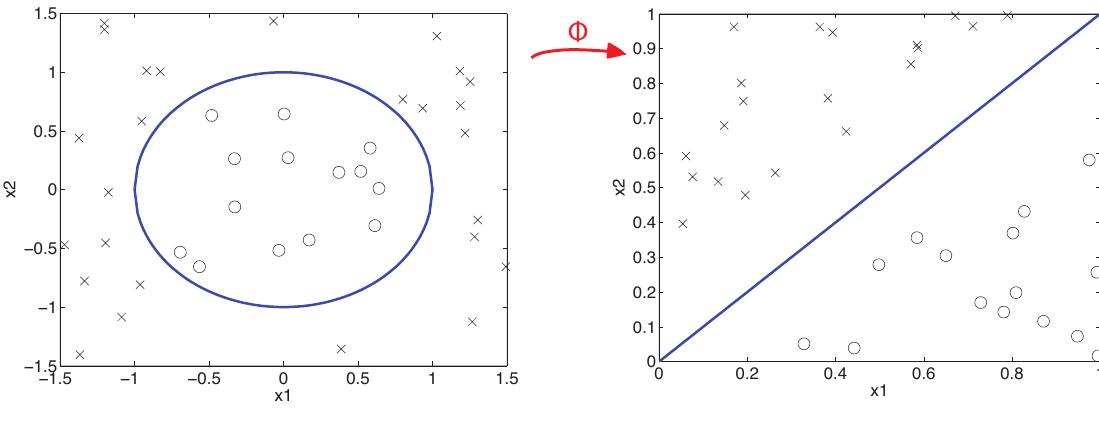
Figure 6. Graphical view of the